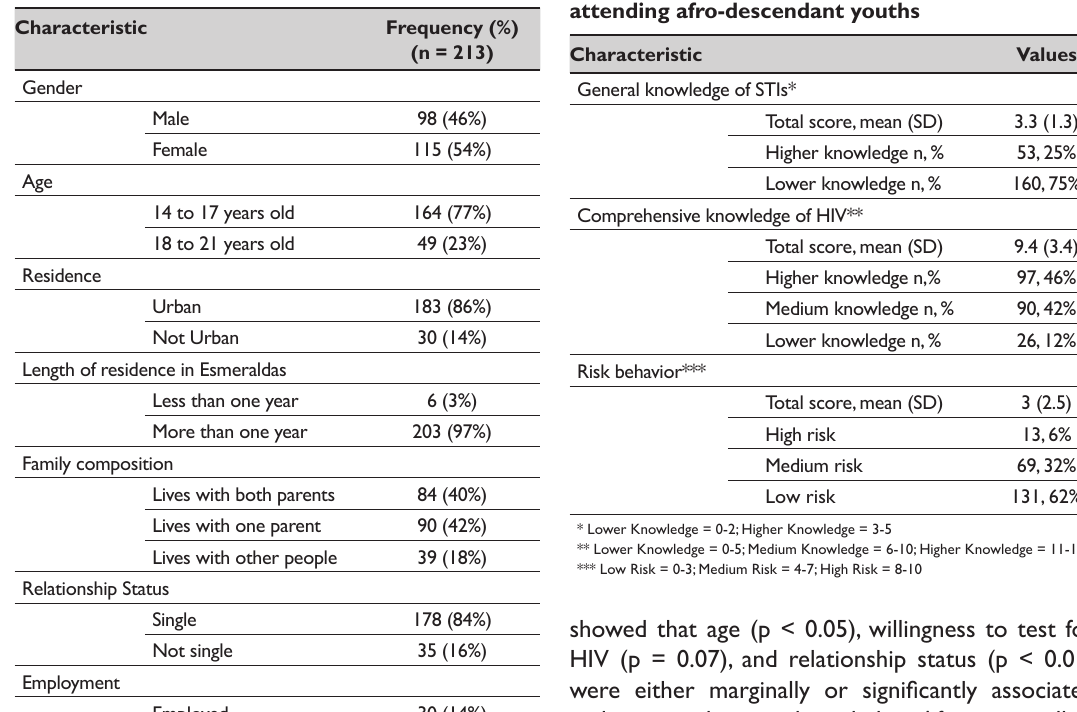
Table 3: Knowledge and behavior among